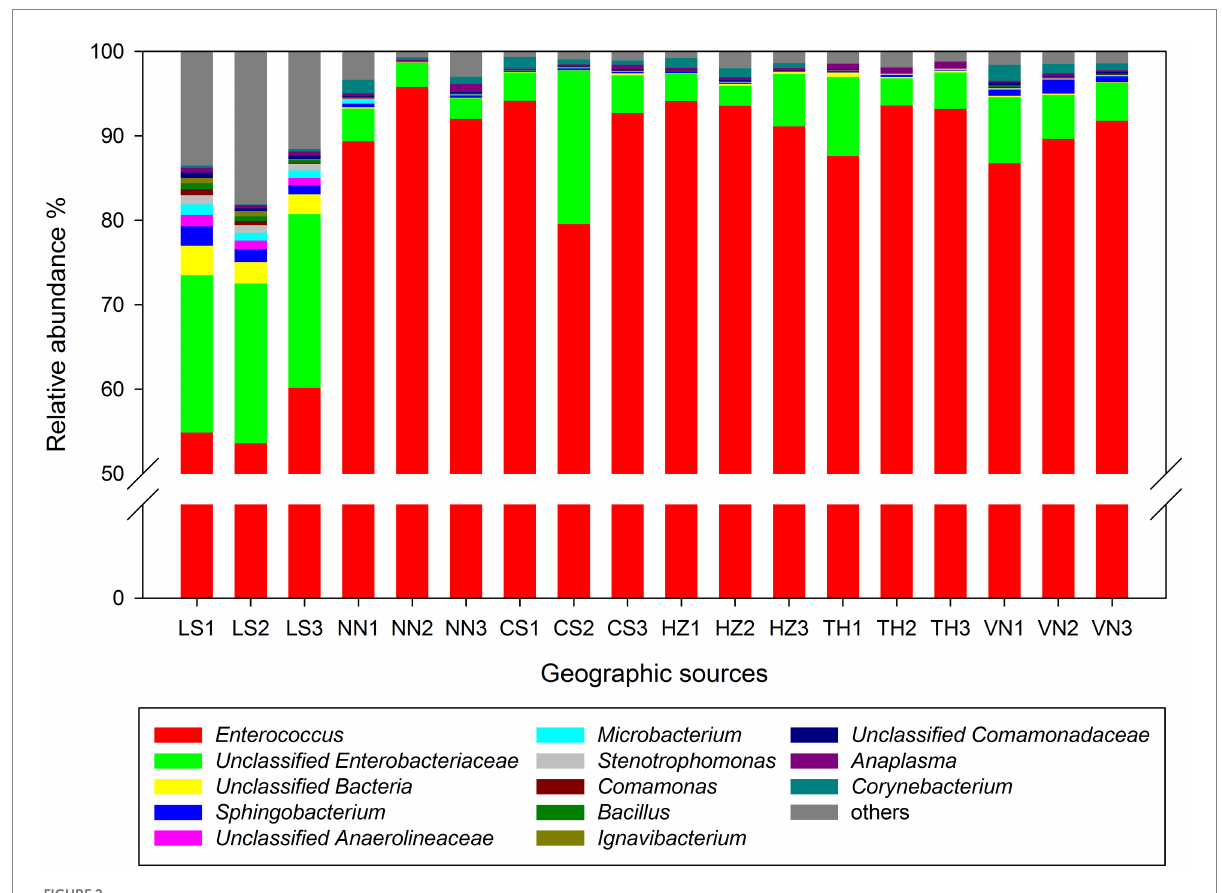
FIGURE 2 Relative abundance of the gut microbiota in C. medinalis from different geographic sources at the genus level.